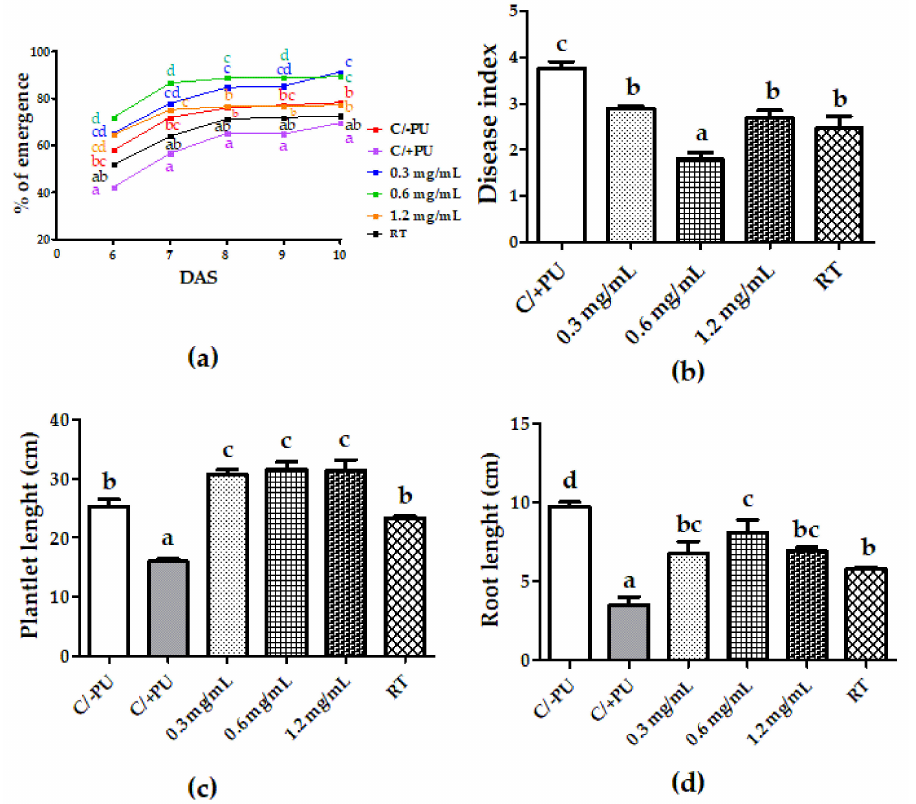
Figure 5. Effect of tomato seed treatment with different concentrations (0.3, 0.6, and 1.2 mg/mL) of Jania adhaerens water-soluble polysaccharides on the emergence of seedlings ( a ), plant length ( b ) and root length ( c ) in a growing substrate infected with Pythium ultimum (PU). C/-PU = non-infected control; C/+PU = infected control; RT = reference treatment (2 mL/L); DAS = days after sowing. In panel ( a ), each value is the mean of 3 independent experiments ( n = 3); different letters indicate significant differences among treatments and controls within each DAS, according to the LSD test ( p < 0.05). In panels ( b – d ), columns are mean values of 3 independent experiments ( n = 3) ± SD. Different letters indicate significant differences among treatments and controls according to the LSD test ( p <